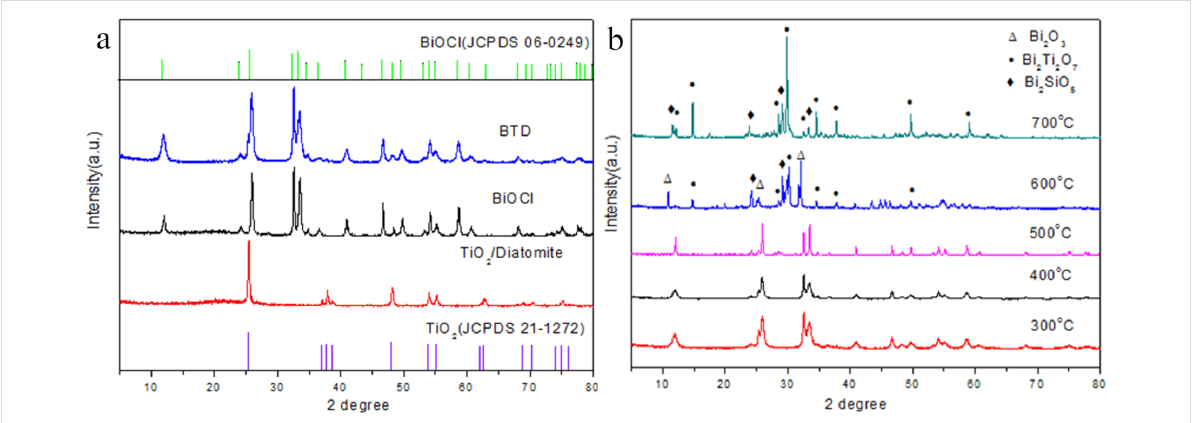
Figure 1: XRD patterns of the TiO 2 /diatomite, BiOCl and BTD (a) and BTD with different calcination temperatures (b).